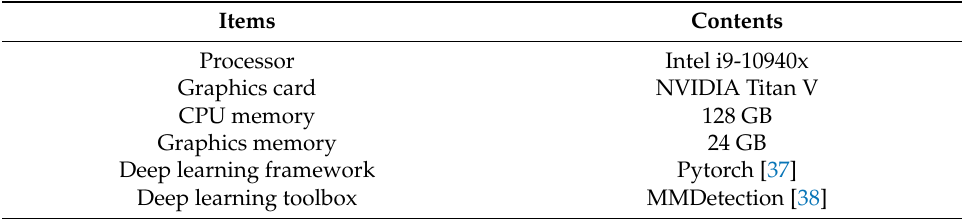
Table 1. Hardware and software environment of experiments.